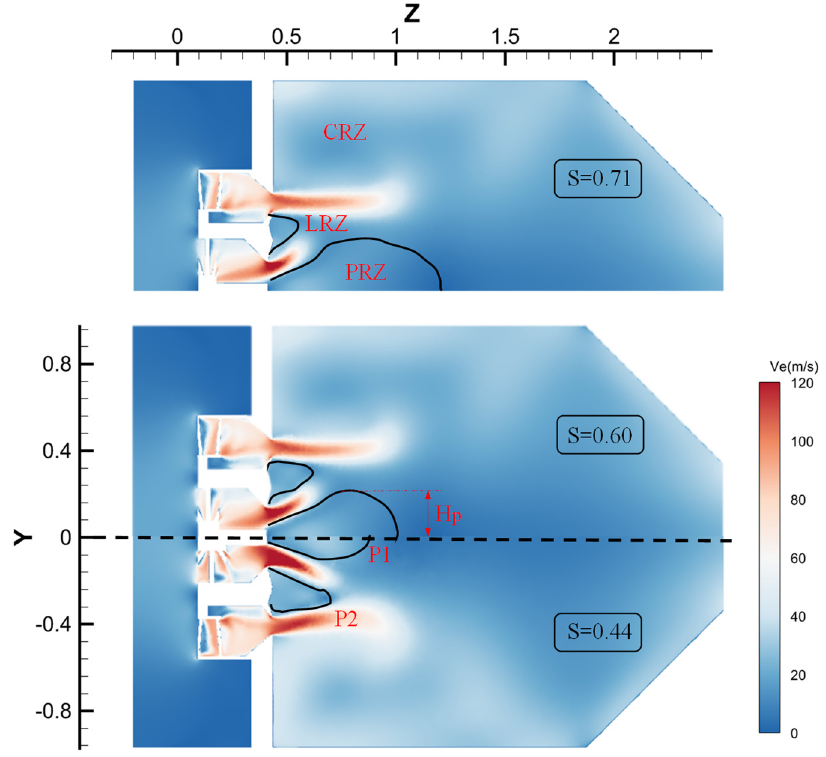
Figure 7. Flow fields of Plane − M with different pilot ‐ stage swirl numbers.